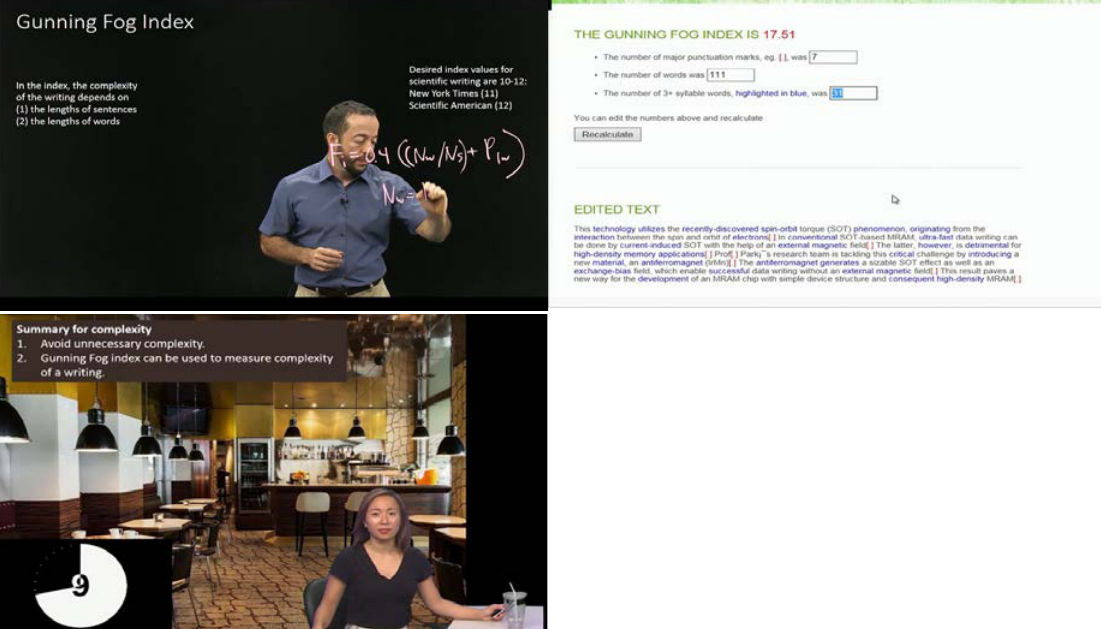
Figure 4 . (Upper left) Treatment Group 4 (high diversity) features the same background, Khan-style writing, and (Upper right) visual as in Treatment Group 3. (Lower left) An additional still of a guest lecturer summary included in the Treatment Group 4 version but not in other treatment versions of the